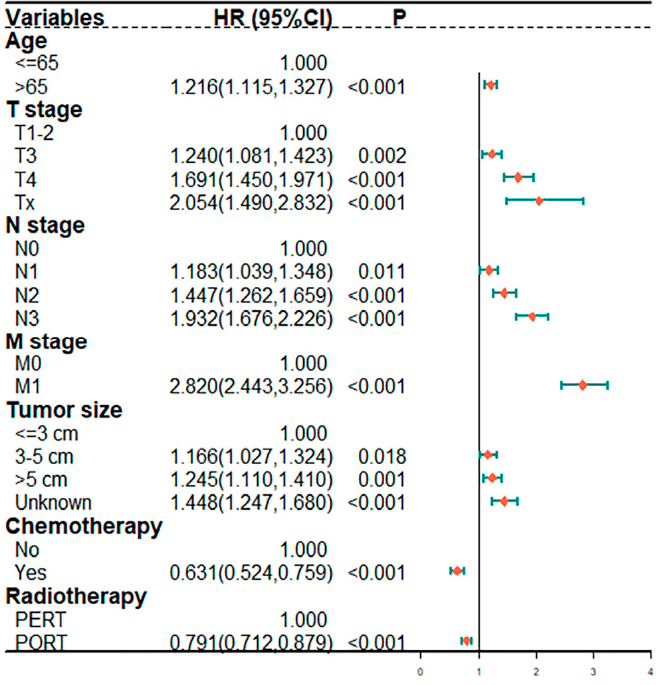
Figure 3. Multivariate analysis for factors associated with OS.